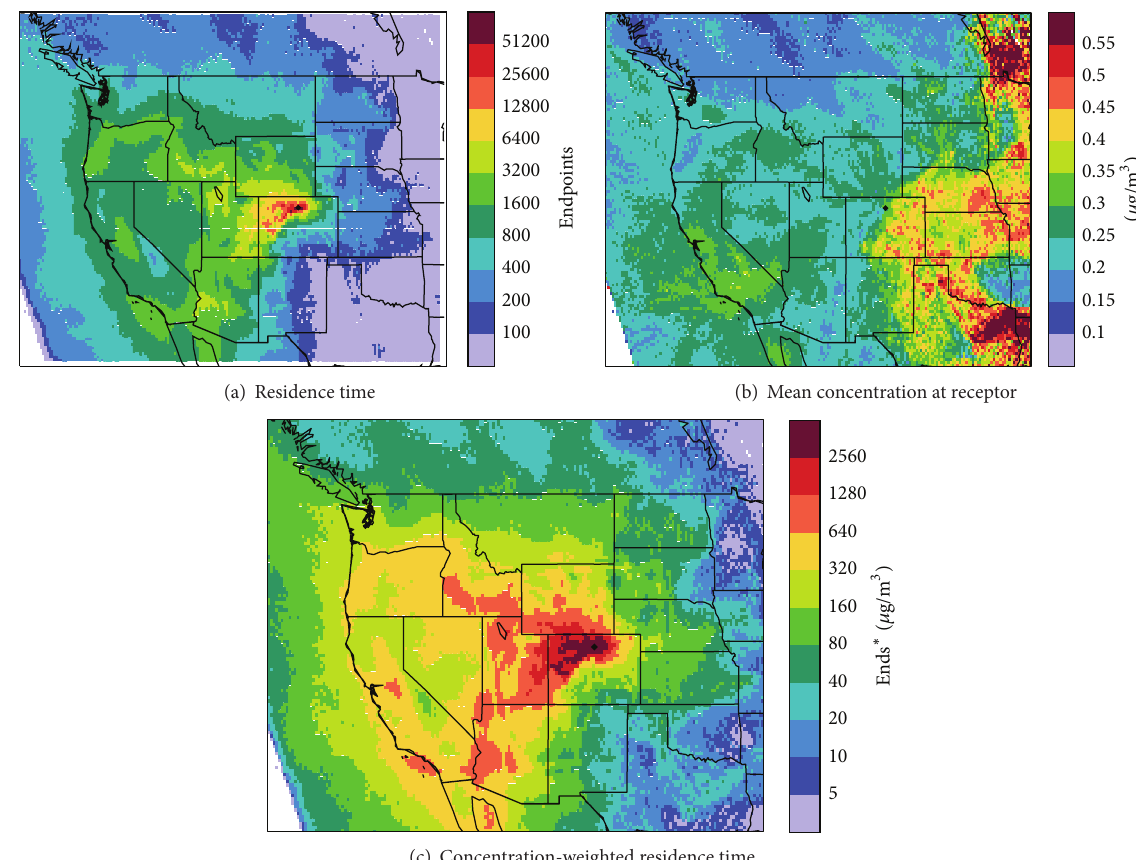
Figure 9: Three analyses of WRF back trajectories for 24-hour measured ammonia at the core site for the study year shown on maps of the Western United States with state boundaries. (a) Overall residence time or likelihood of an air mass arriving from each grid cell. (b) Mean ammonia concentration at the receptor when air mass arrived from each grid cell. (c) Concentration-weighted residence time. The distance from the Pacific Coast to the eastern edge of each map is approximately 2500 km.